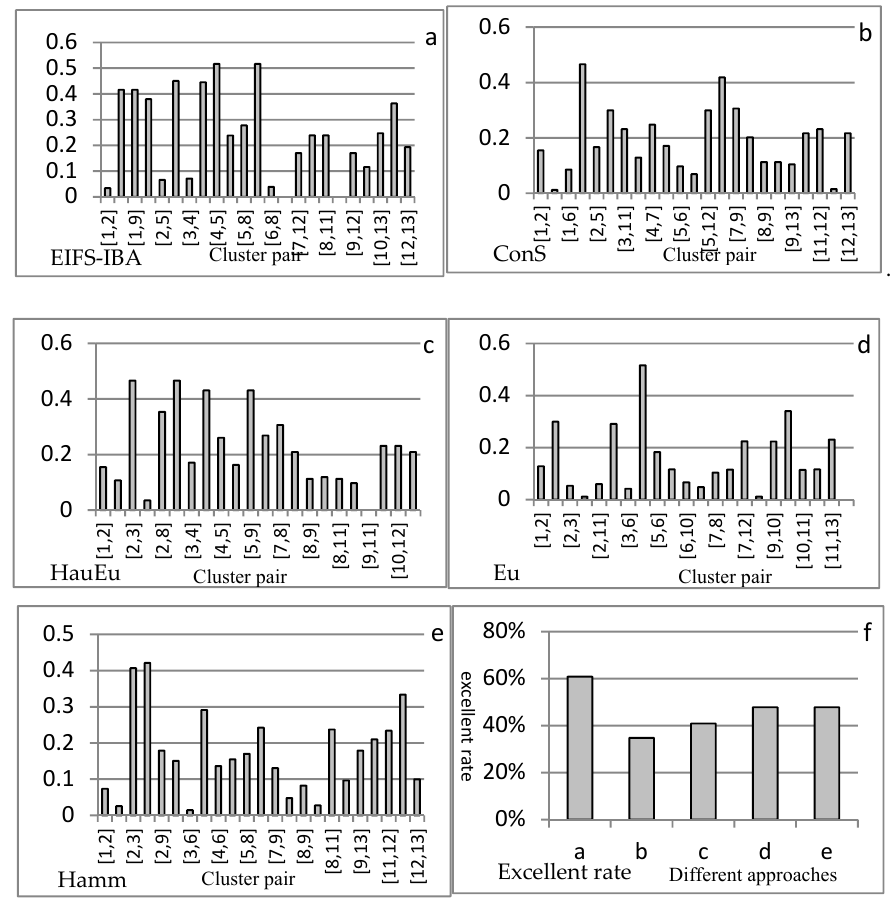
Figure 10. The ICGF differences and excellence rates, where ( a – f ) corresponded to the EIFS-IBA, ConS, HauEu, Eu, and